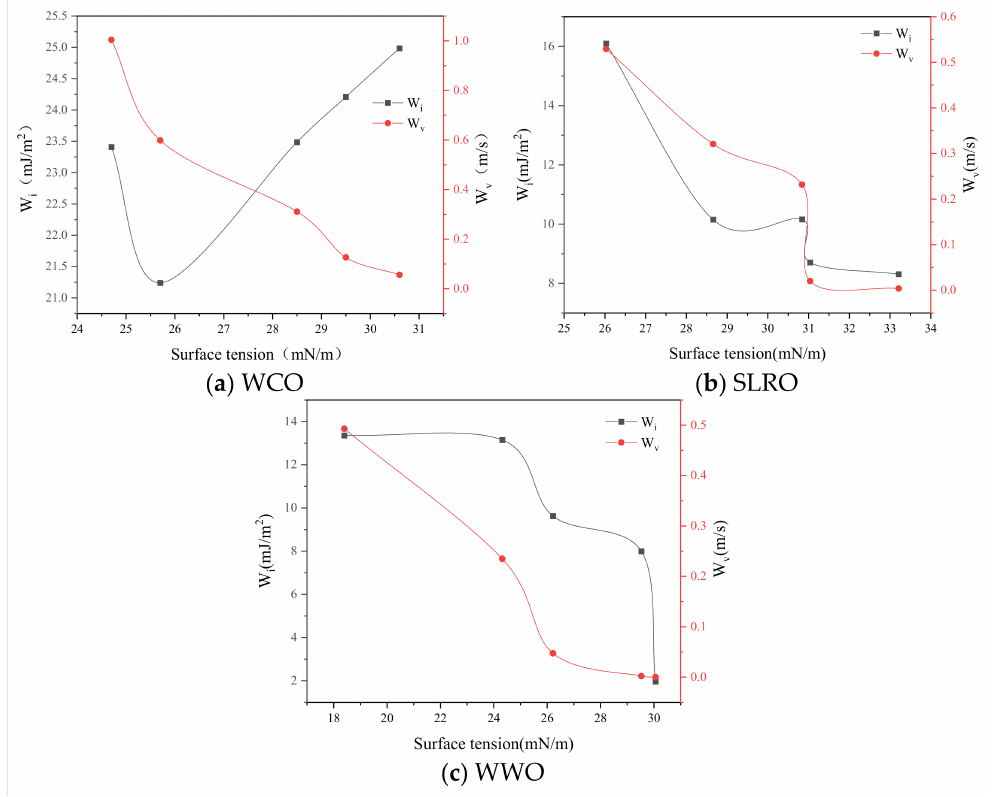
Figure 10. Influence of surface tension on